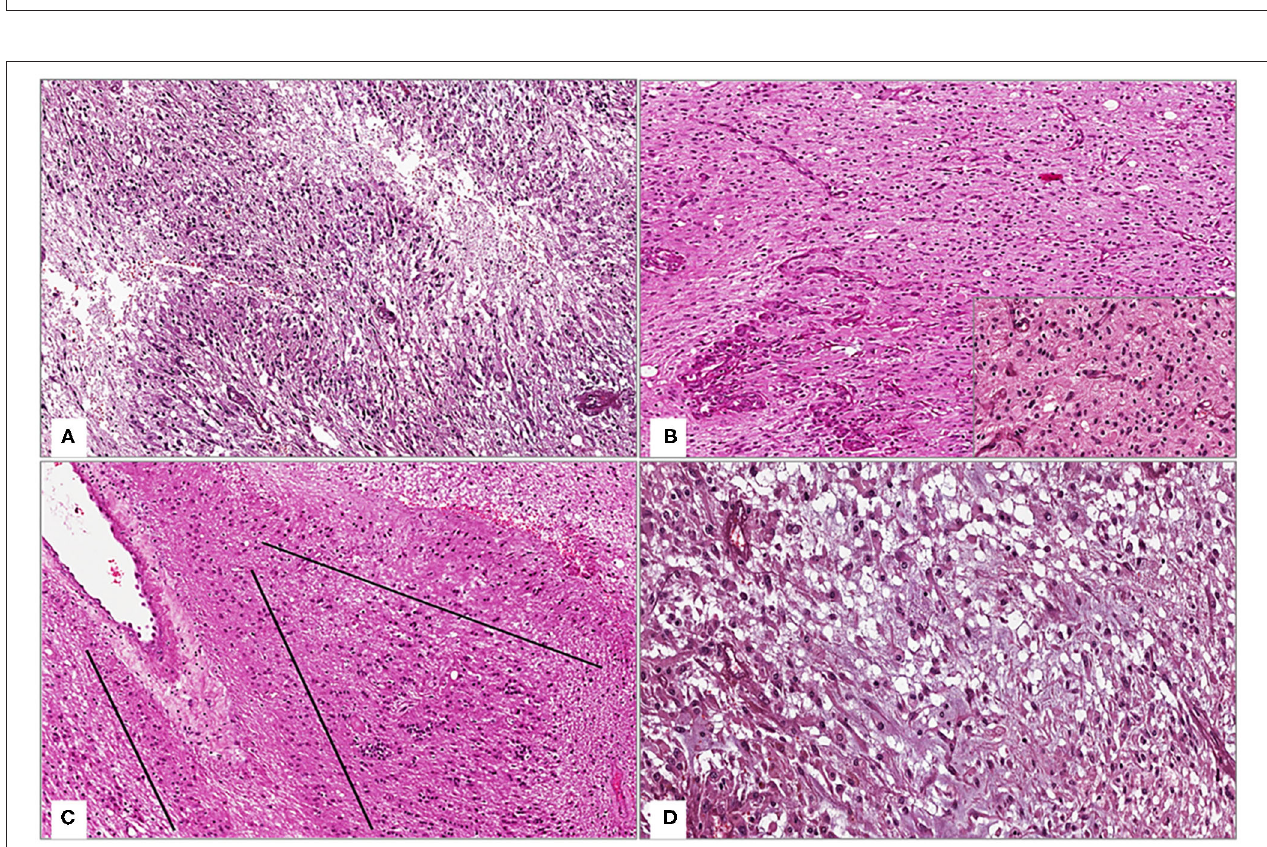
FIGURE 2 | (A) Low magnification showing the conventional morphology of WHO grade IV glioblastoma, IDH-wild type: a moderately cellular astrocytic tumor with foci of pseudopalisading necrosis (hematoxylin and eosin; original magnification 150x); (B) Tumor exhibits, as an unusual morphologic feature, more bland-looking areas composed of monomorphous round-shaped cells and thin capillary-like vessels with “chicken-wire” pattern, arranged in an endocrinoid pattern (insert); these features are also found close to foci of microvascular proliferation [hematoxylin and eosin; original magnifications 150x and 300x (insert)]; (C) Tumor areas with nuclear palisading (lines) are seen (hematoxylin and eosin; original magnification 150x); (D) Spindled neoplastic cells set in a loose, myxoid background, imparting to the tumor a focal “tissue culture-like” morphology (hematoxylin and eosin; original magnification 300x).